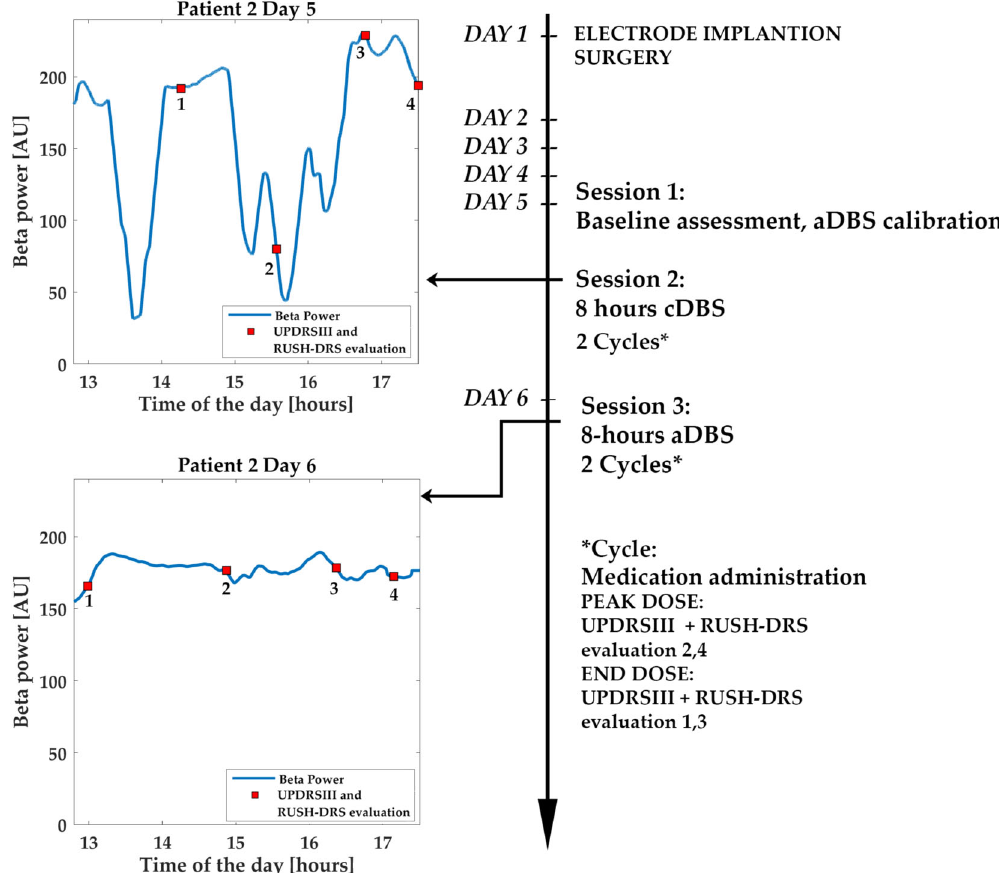
Fig. 2 Local fi eld potential power as recorded during the cDBS and aDBS sessions by AlphaDBS with evaluation time-points and overview of the protocol. The signal is sampled at 1 sample/s and the time format in the x -axis is